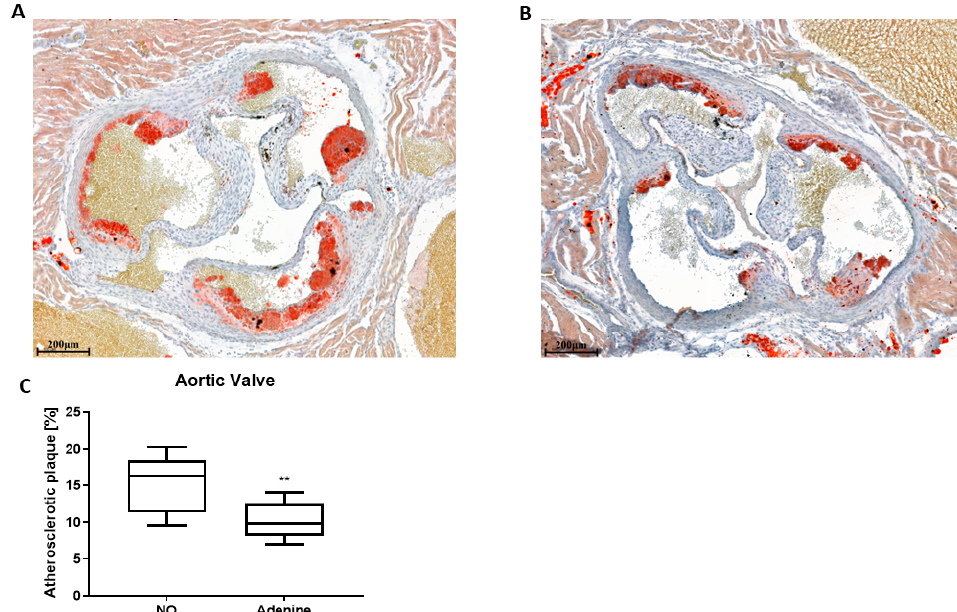
Figure 3. Adenine-induced nephropathy leads to a reduction of atherosclerotic lesions. ApoE KO mice were fed for 2 weeks with WD-CAC, followed by 5 weeks with WD-CAC ± adenine and atherosclerotic lesions were quantified in the aortic valve. ( A ) Representative ORO staining of aortic root sections from control mice and ( B ) mice with adenine-induced nephropathy. ( C ) Quantification of aortic lesions in the aortic valve. NO represents the control group, fed with WD-CAC. Scale bar = 200 μ m. The data is plotted as a median with whiskers indicating the minimum and maximum values ( n = 7–8). For statistical significance, ** p < 0.01.